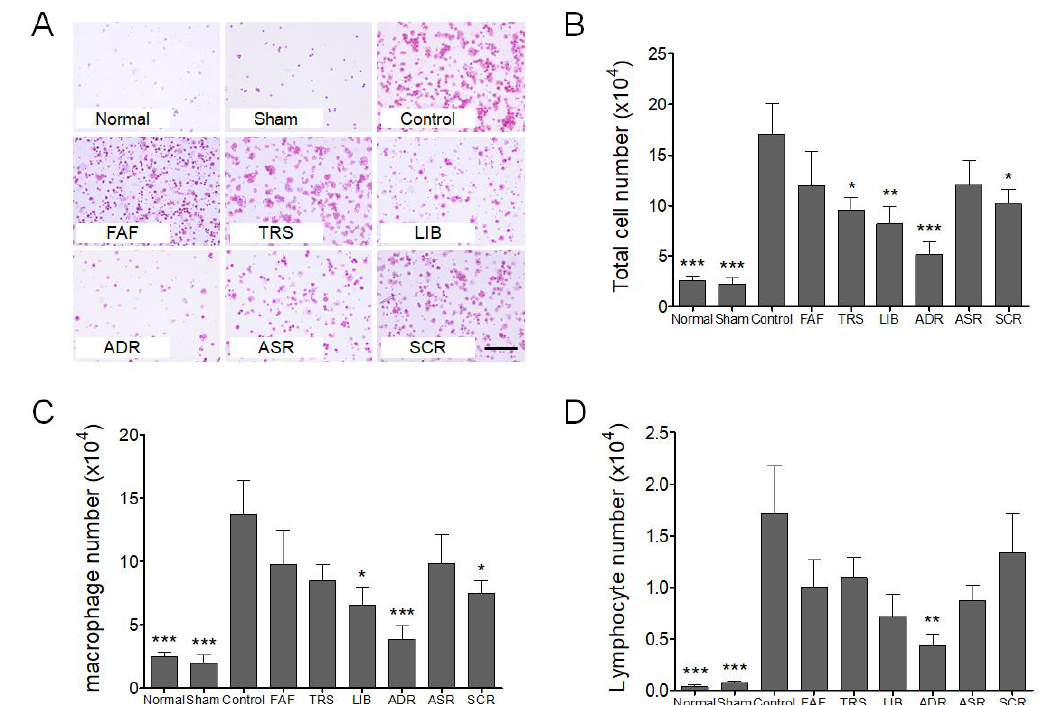
Figure 2. Inflammatory cell counts in the Bronchoalveolar fluid of each group. The typical image of inflammatory cell distribution in each group ( A ), the graph of the total cell number ( B ), macrophage number ( C ), and lymphocyte number ( D ), respectively. The magnification of A is 200×. Scale bar is 400 μm. FAF, Farfarae Flos; TRS, Trichosanthis Semen; LIB, Lilii Bulbus; ADR, Adenophorae Radix; ASR, Asteris Radix; SCR, Scrophulariae Radix. * represents statistical differences from control group (* p < 0.05, ** p < 0.01, *** p < 0.001).